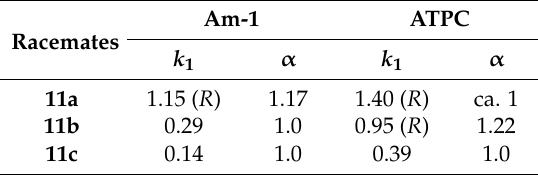
Table 1. Resolutions of racemates on Am- 1 - and ATPC-based CSPs. Am-1 ATPC Racemates k 1